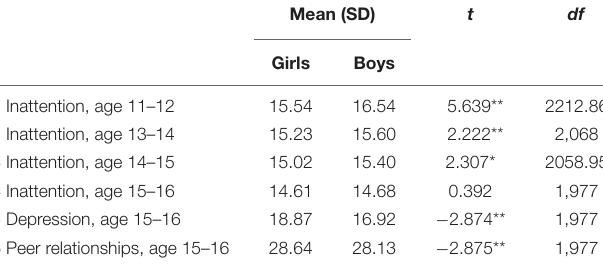
TABLE 4 | Results of t -test about sex difference (Panel 2).